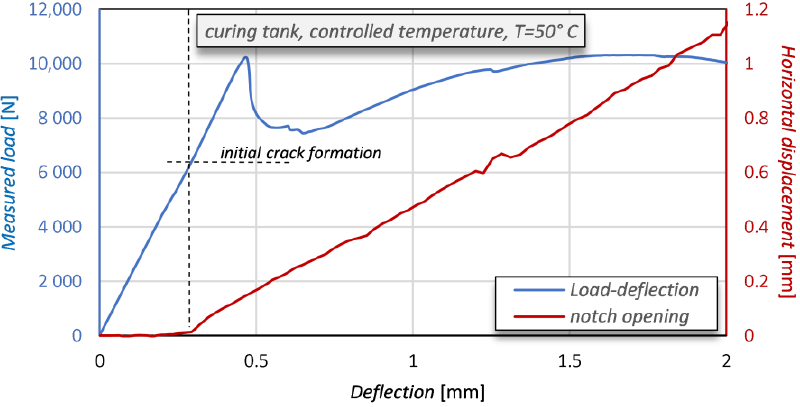
Figure 15. Opening of the notch of the concrete beam (in red) and load-deflection curve (in blue).